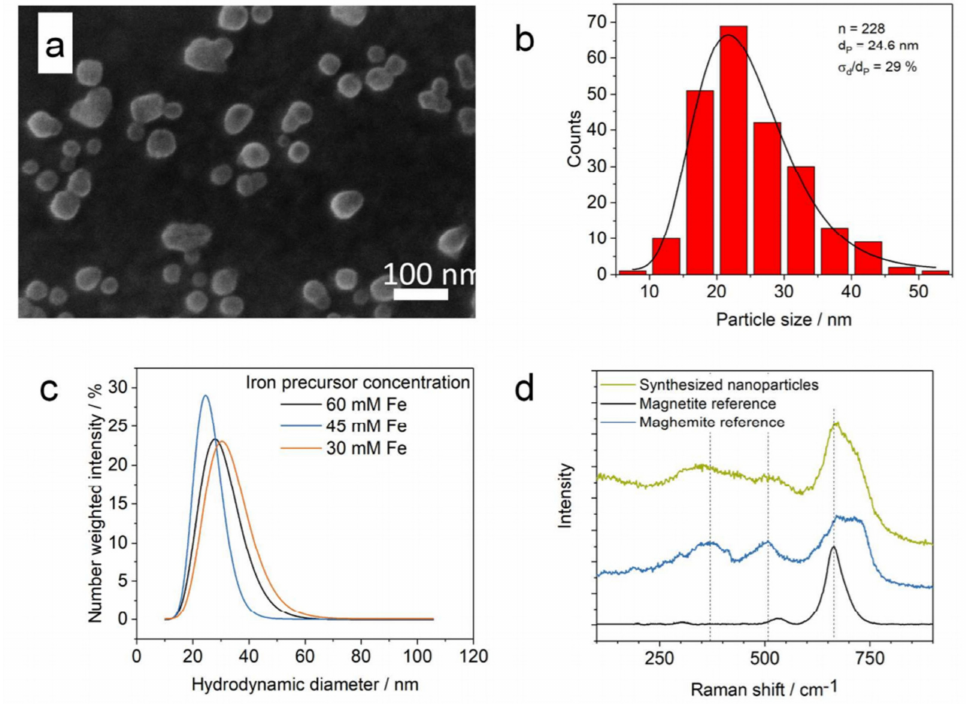
Figure 5. ( a ) Field emission scanning electron microscopy (FESEM) image of the magnetic iron oxide nanoparticles synthesized in [55]. ( b ) The particle size distribution. Here n, d p , and σ p /d p stand for the particle quantity, particle diameter, and the relative standard deviation at the lowest base concentration, respectively. ( c ) Number weighted intensity versus the hydrodynamic diameters, measured by dynamic light scattering (DLS), is plotted. ( d ) Raman spectra of the nanoparticles are illustrated. Reprinted with permission from J. Bemetz, et al., 2018 Analytical Chemistry